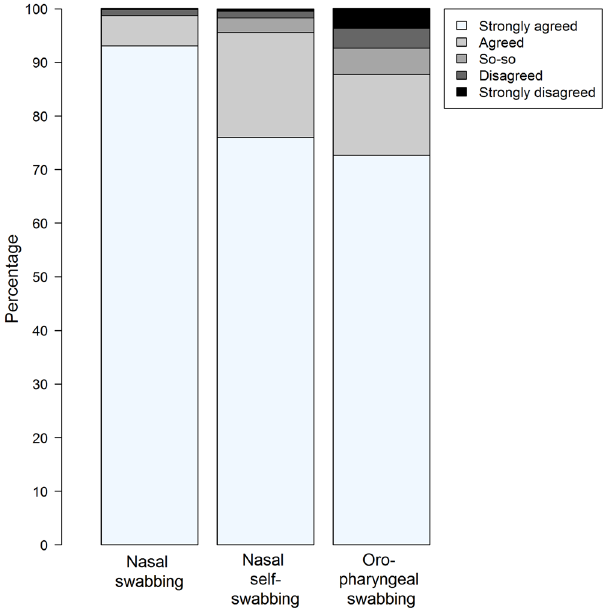
Figure 3. Acceptance of nasal and oropharyngeal swabbing. Responses to the following 3 statements were evaluated using the Likert scale shown in the legend: (1) Collection of the nasal swabs by the study personnel was acceptable to me; (2) Collecting the nasal swab at home was acceptable to me; (3) Collection of the throat swab by the study personnel was acceptable to